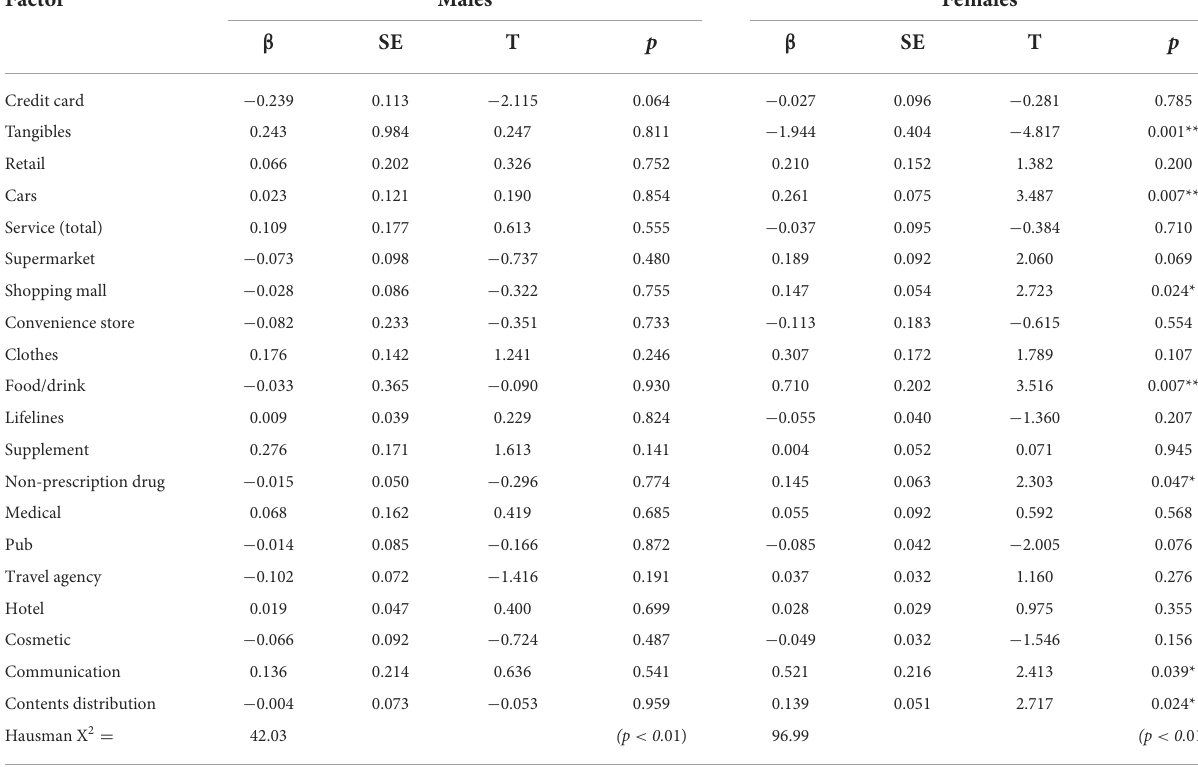
TABLE 3 Relationship between personal consumption expenditures and SDRs for males and females in their twenties in the metropolitan region during the COVID-19 pandemic (between March 2020 and December 2021).